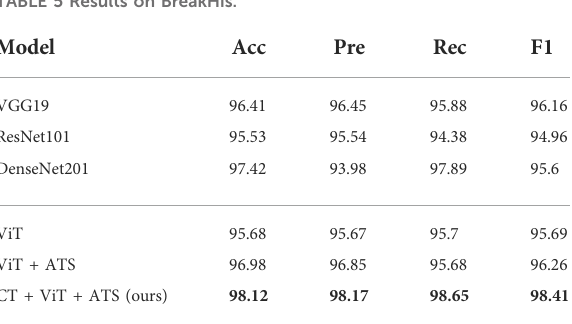
TABLE 5 Results on